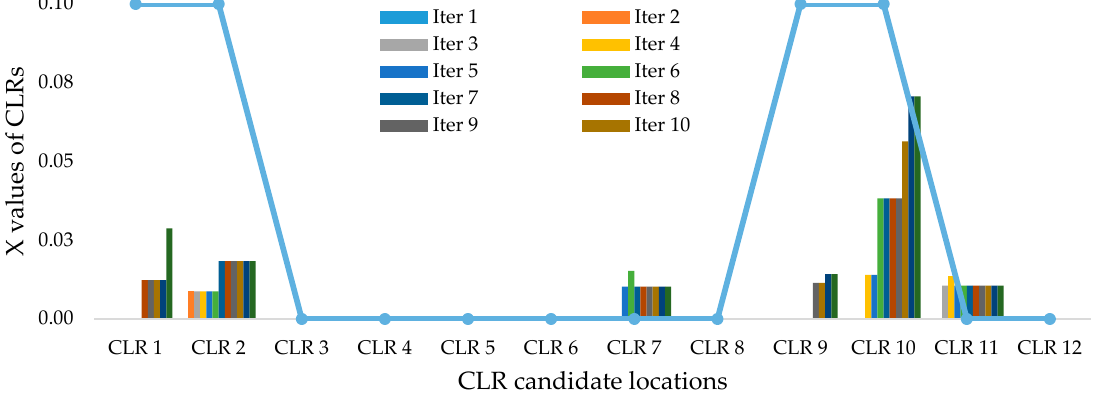
Figure 8. Set of CLR 𝑋 variables at each iteration in Case 2.